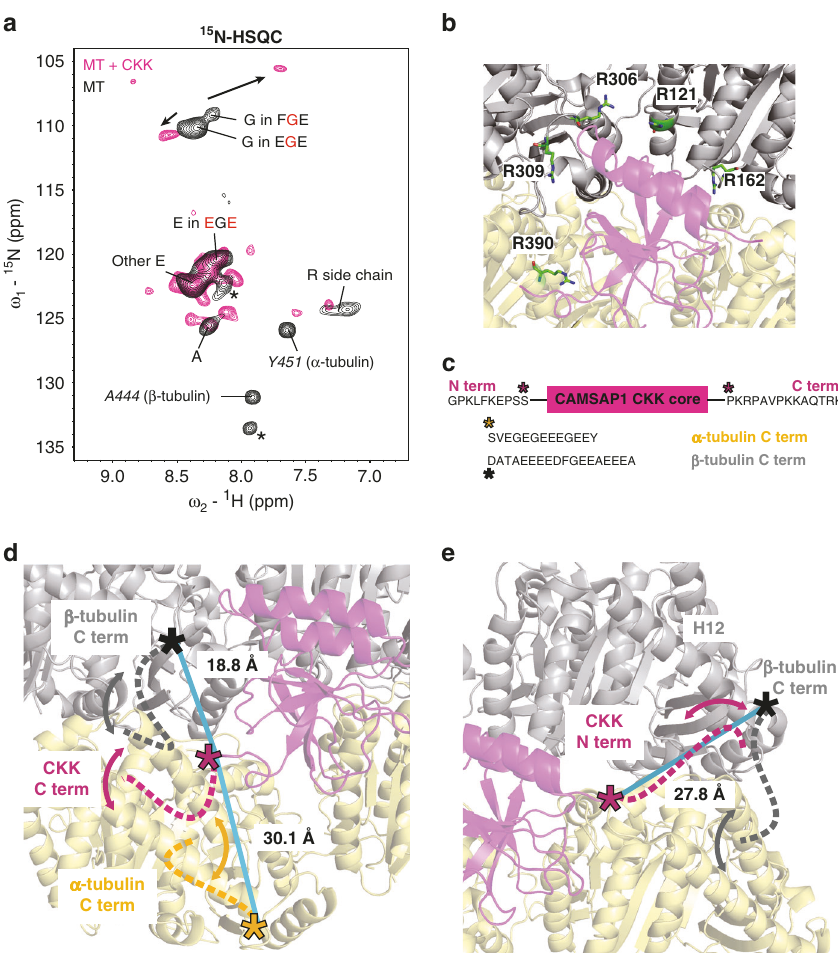
Fig. 4 Tubulin C-terminal tail dynamics are modulated by the CKK domain. a Comparison of 2D 15 N-HSQC spectra obtained from [ 13 C, 15 N]-labeled MTs (black) and unlabeled CAMSAP1 CKK N1492A in complex with [ 13 C, 15 N]-labeled MTs (magenta). b Zoom-in on arginine residues found in the CKK-MT cryo-EM structure (PDB 5M5C), ref. 15 ) that are located on α -tubulin (yellow) and β -tubulin (gray) and within 6 Å to CKK domain (magenta). c Top: amino- acid sequences of CKK termini with last residues observed in the cryo-EM structure (PDB 5M5C) indicated by stars. Bottom: C-terminal tails of α -tubulin and β -tubulin with last residues detected the cryo-EM structure (PDB 5M5C) are indicated by yellow and black stars, respectively. d Dynamic (indicated by double-headed arrows) C-terminal tubulin (dashed black and yellow lines) and CKK (magenta) tails. Blue lines measure the distance between the last residues observed in the cryo-EM structure of both tubulin tails (indicated by black and yellow stars) to the last CKK C-terminal residue observed in cryo- EM (magenta star). e Dynamic (indicated by double-headed arrows) CKK N-terminus (dashed magenta line) and β -tubulin C-terminus (dashed black line). The blue line indicates the distance between the last residue of β -tubulin and the fi rst residue of CKK detected in the cryo-EM